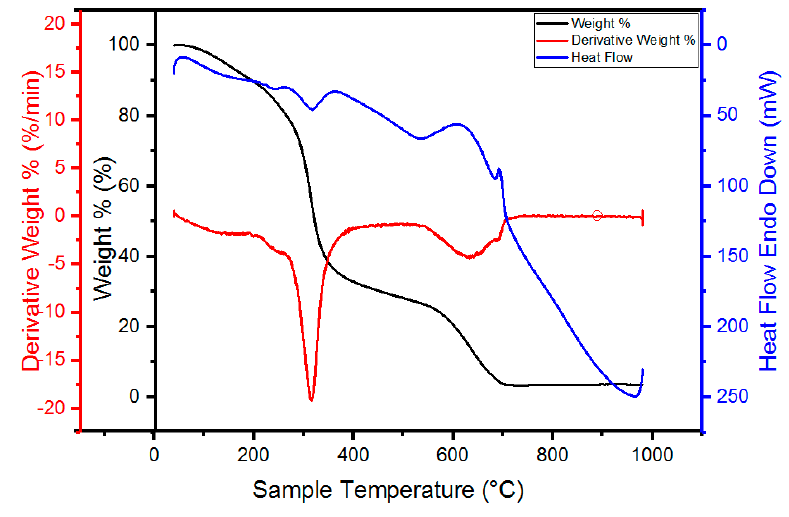
Figure 4. TGA curve for the S5.